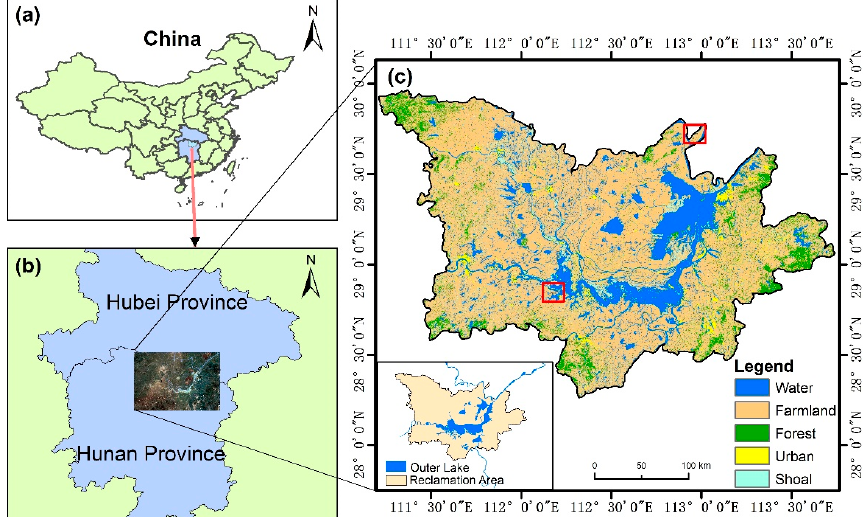
Figure 1. Geographic location and land cover map of the study area: ( a ) general location in China; ( b ) location in Hunan Province; ( c ) 1997 land-use classification (prior to Converting Farmland to Lake (CFTL) implementation) from Google Earth Engine (GEE) imagery (see Section 2.3). The red frames show the location of the two typical CFTL areas.